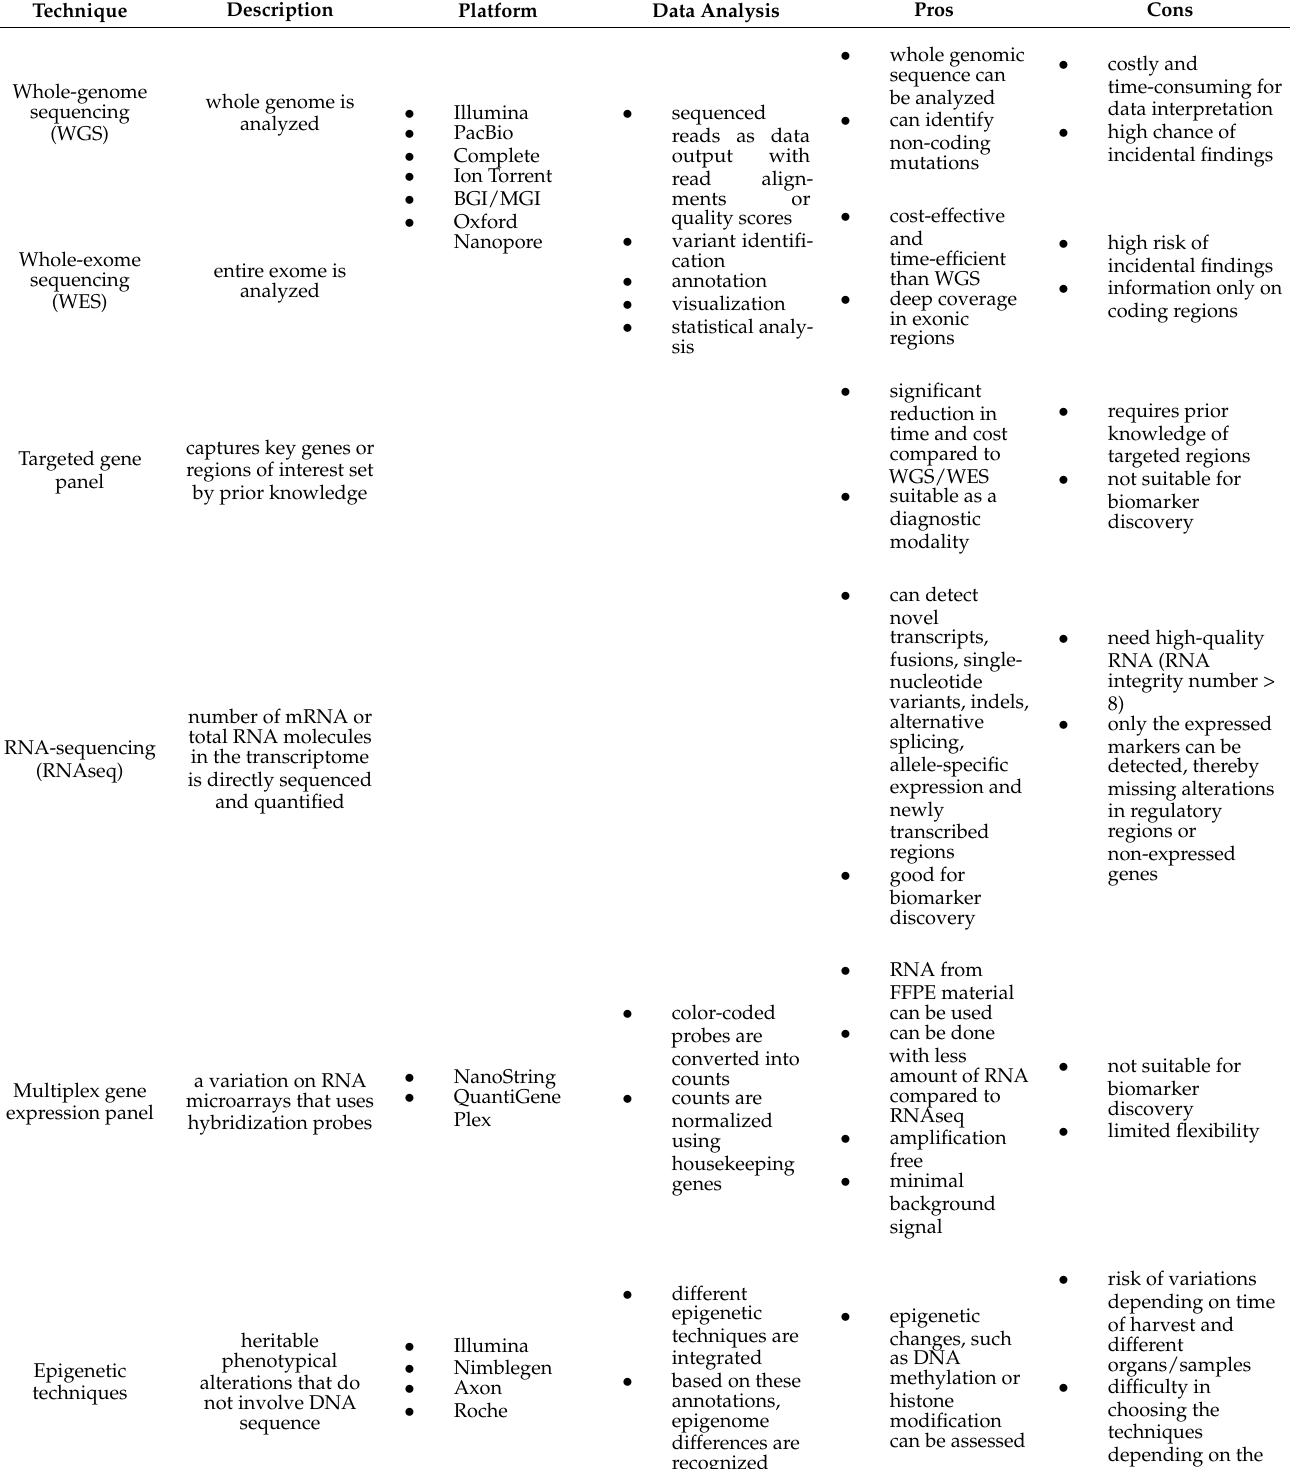
Table 1. Summary and comparison of various diagnostic